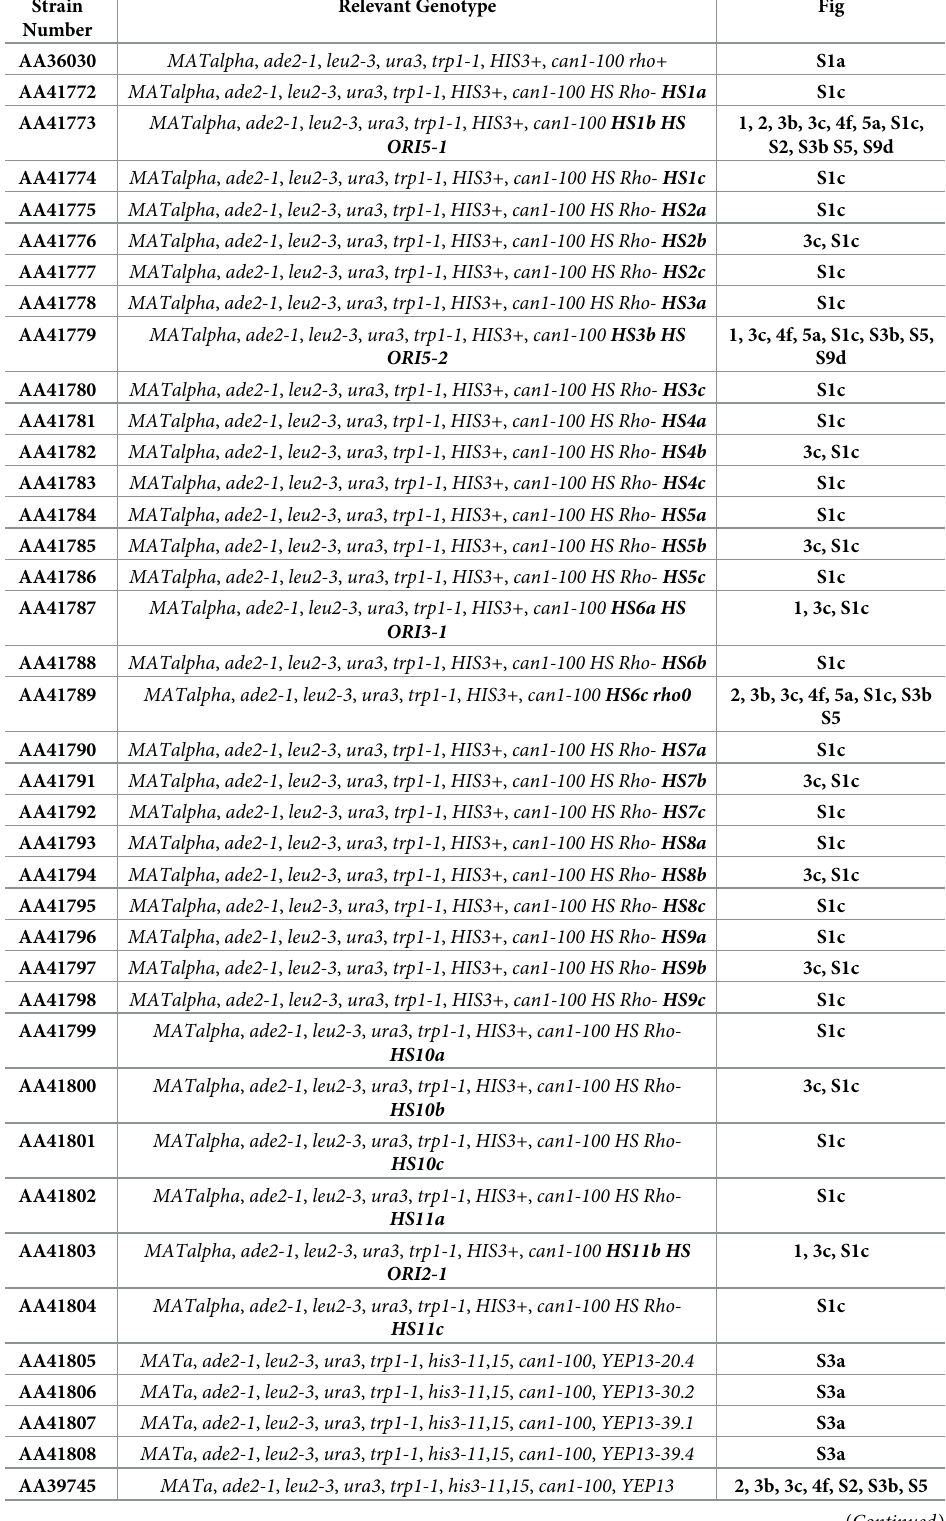
Relevant Genotype